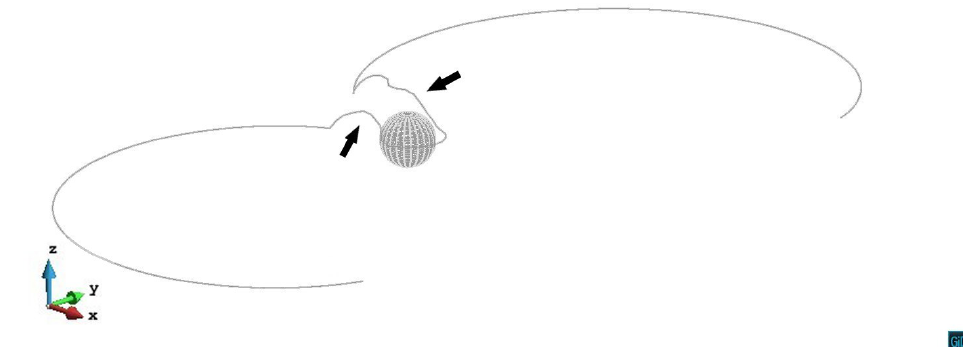
Figure 19. Snapshot of the dislocation cross-slip (black arrows) on z / R = 0.2 plane. The plastic strain ε = 1.46 × 10 − 4